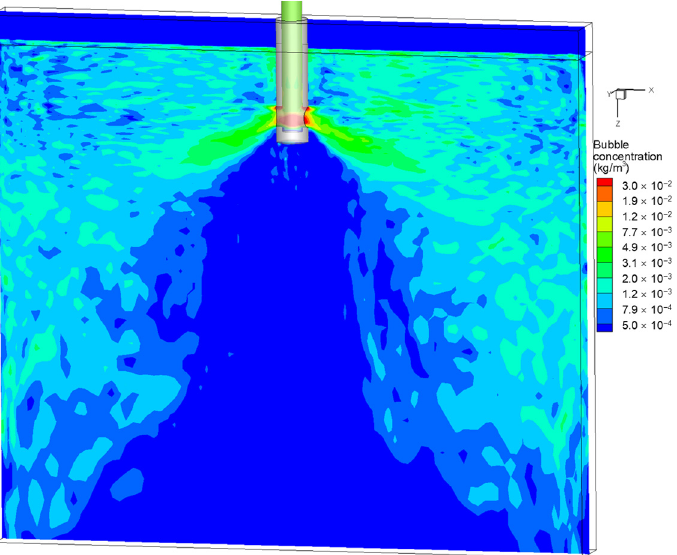
Figure 9. Spatial distribution of bubbles at t = 90 s.